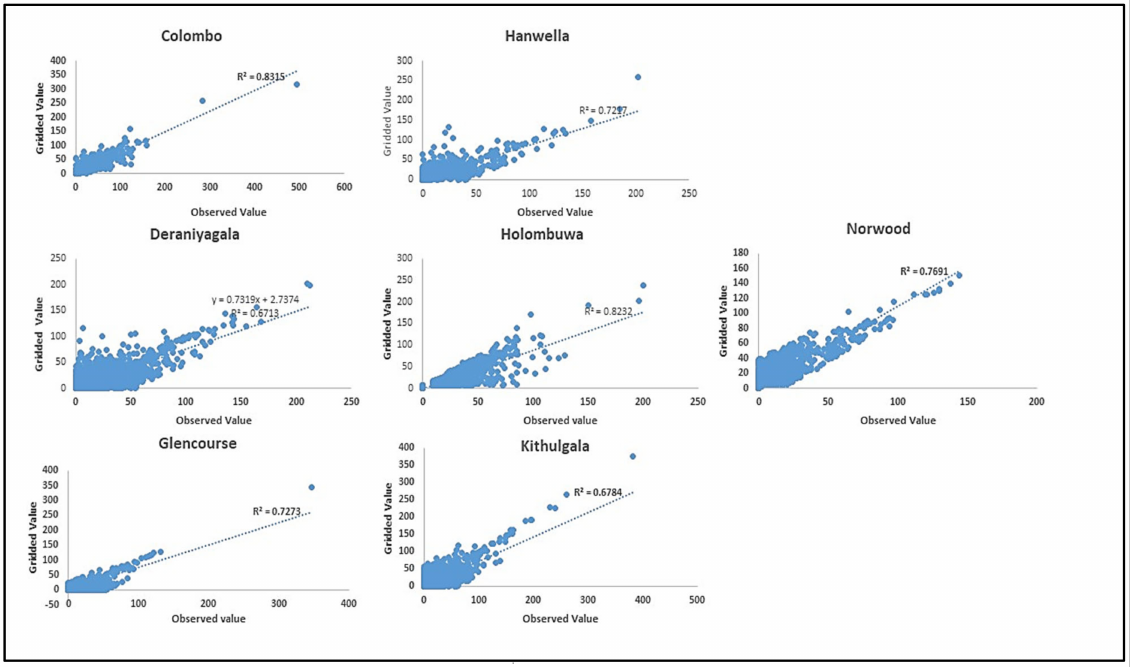
Figure 2. Scatter plots the output and R 2 for observed and gridded daily rainfall at the seven KRB